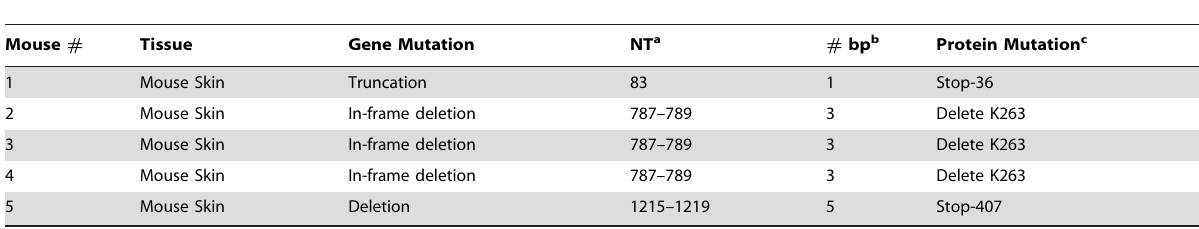
Table 4. Mutations found in covS gene of GAS strain Manfredo M5/ covS + during infection.